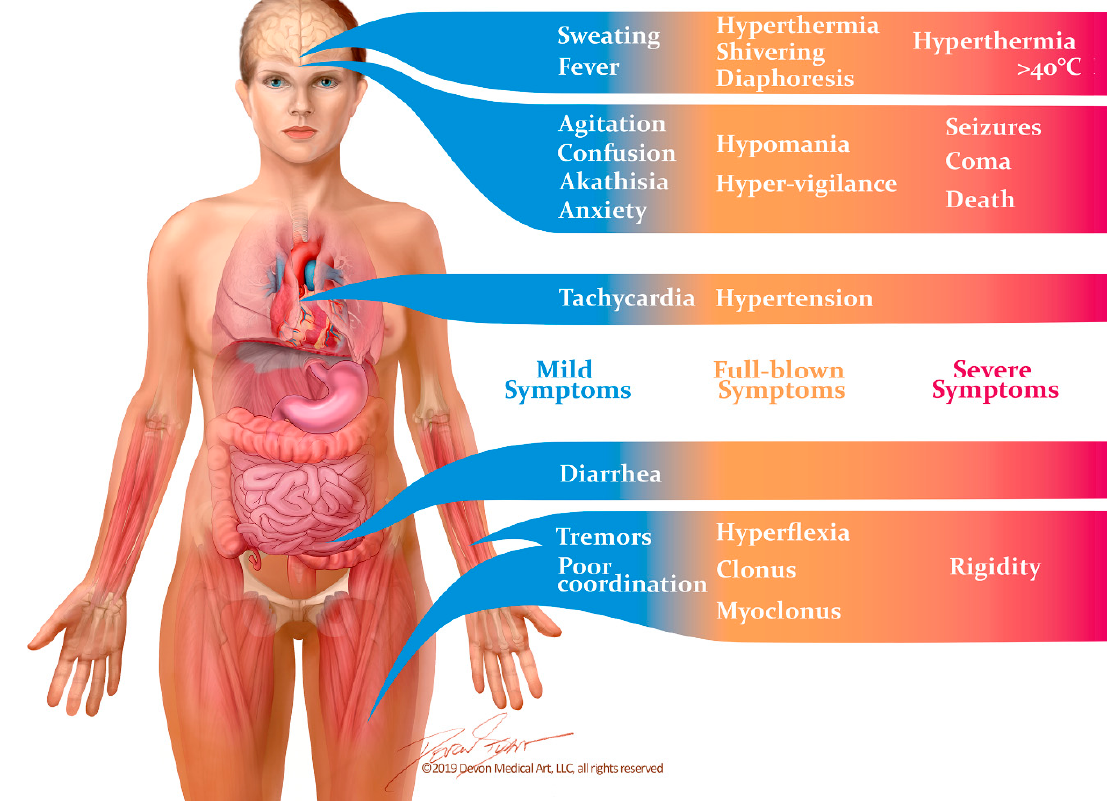
Figure 1. Signs and symptoms of the serotonin syndrome occur along a spectrum of severity. Mild symptoms may easily be overlooked, and may manifest as little more than diarrhea and flu-like symptoms. Unless the disease is recognized and the causative drugs are discontinued, it can rapidly progress to muscle rigidity, severe hyperthermia and